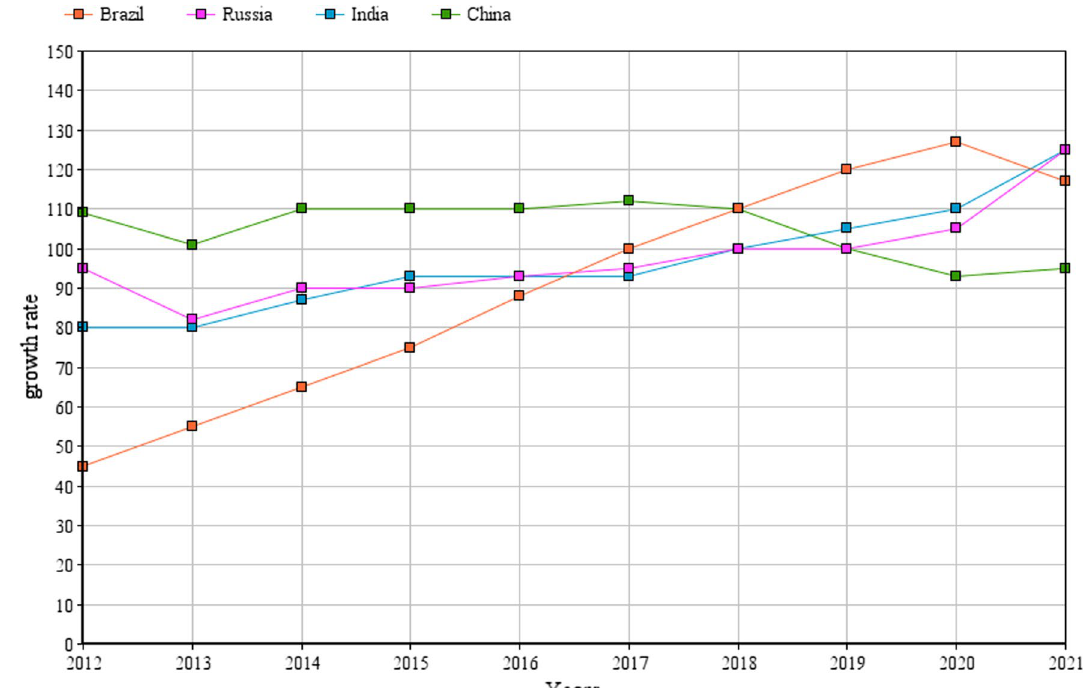
Fig. 1 Statistical data on global industrial growth (Radulescu IG et al. 2021, Christina Majaski. 2020, Svetlana Gusarova. 2019, Rachel S Salz- man. 2021) (Standard of Fig. 1 is improved including